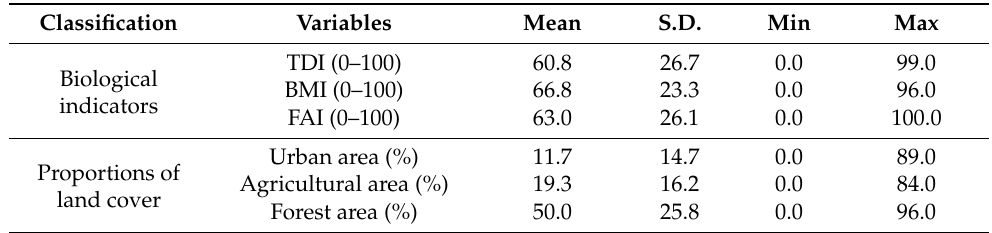
Table 3. Descriptive statistics of biological indicators, percentage of land cover types, and the spatial patterns in the riparian buffer